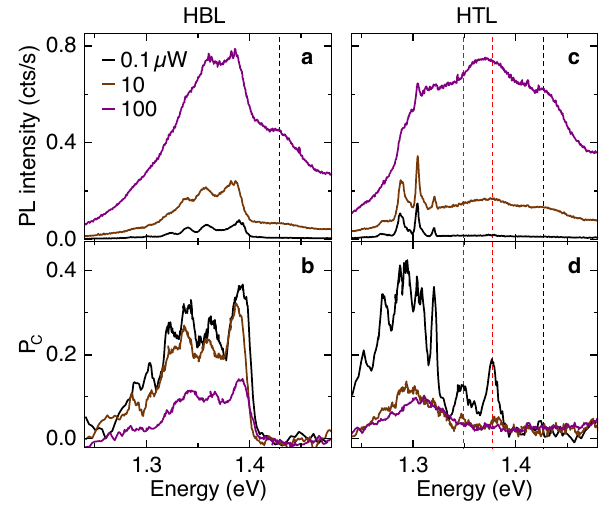
Fig. 3 Power-dependent photoluminescence and degree of circular polarization of MoSe 2 -WSe 2 heterobilayer and heterotrilayer. a , b Photoluminescence spectra and degrees of circular polarization ( P C ) for twisted HBL MoSe2-WSe2 at 0.1 (black), 10 (brown), and 100 μ W (purple) excitation power. c , d Same for HTL MoSe2-WSe2. Dashed lines indicate hot luminescence at the higher-energy side of the interlayer exciton spectrum with zero (black) and fi nite (red) P C